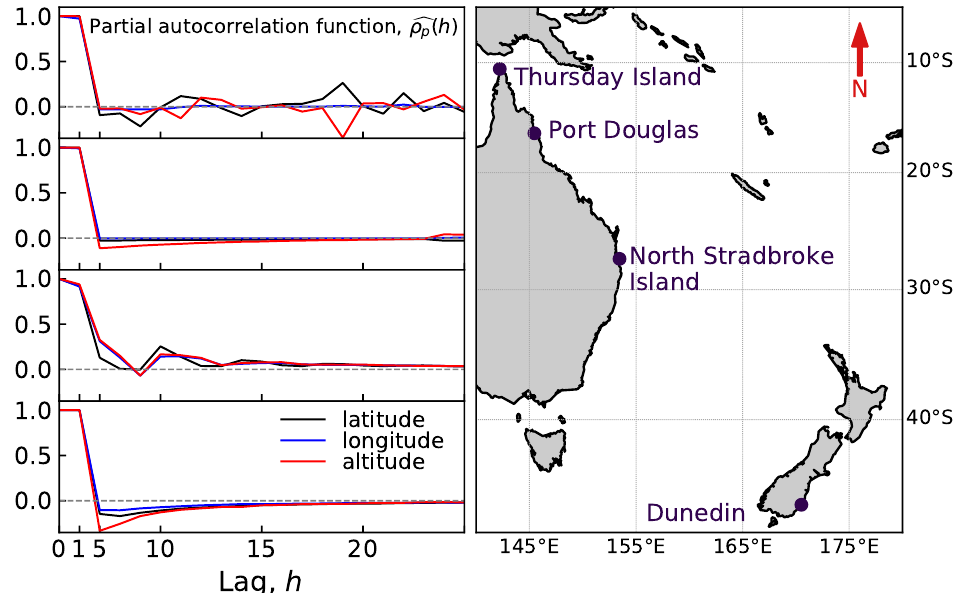
Figure 1. Map of GPS receiver locations for the datasets considered. A single GPS receiver was located at different times at the labelled locations: Dunedin (New Zealand) and North Stradbroke Island, Port Douglas and Thursday Island (Australia). The map demonstrates the spread of the four testing sites, indicating that the observed correlation patterns cannot be attributed solely to an unfortunate “bad” geographic location. The partial autocorrelation functions, ˆ ρ p ( h ) , for latitude, longitude and altitude are shown on the left for the four geographical locations as a function of the lag, h , measured in